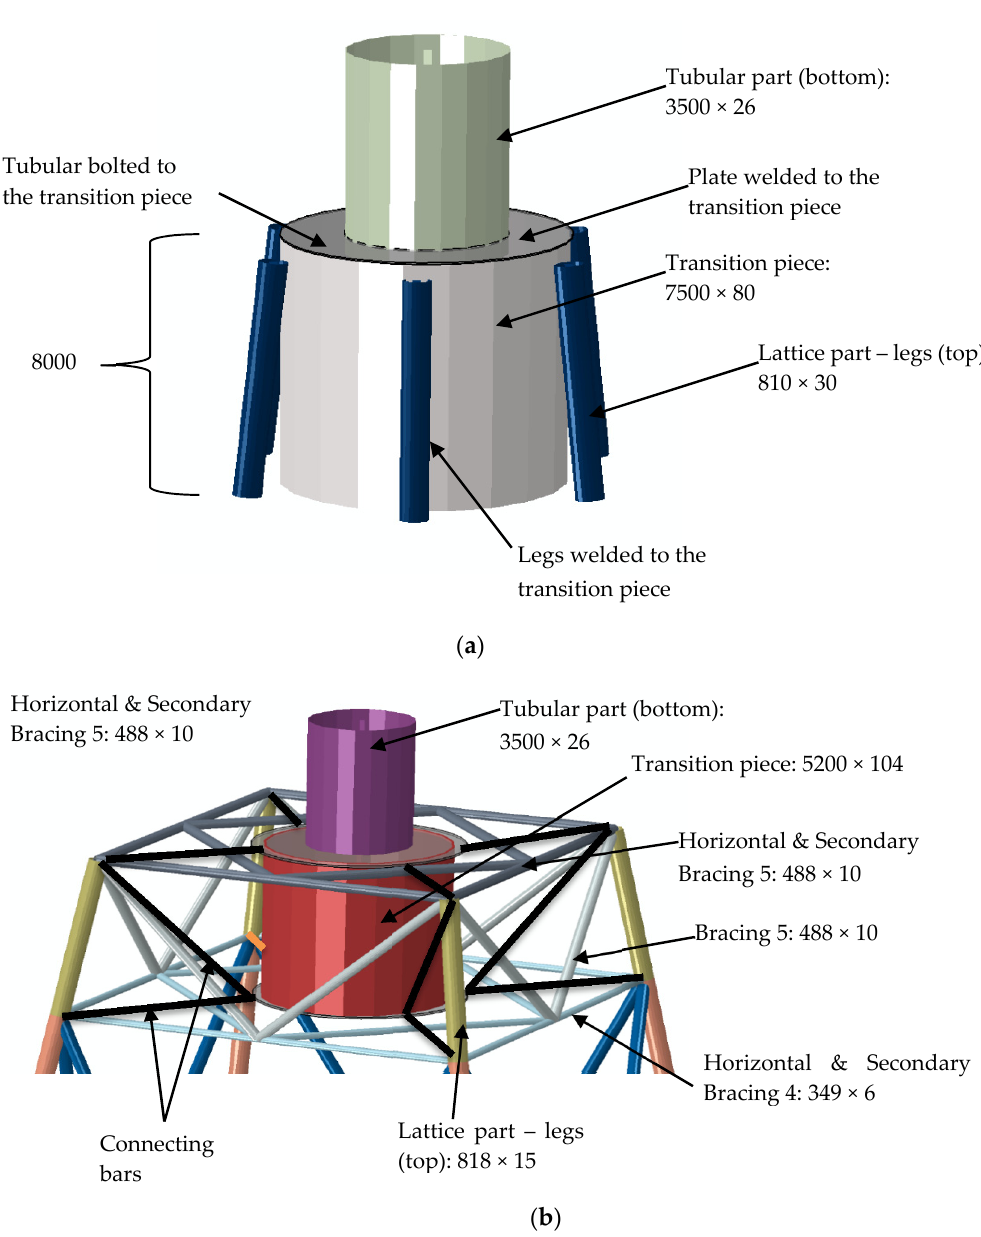
Figure 3. Transition piece (dimensions in mm). ( a ) A 6-legged tower, ( b ) A 4-legged tower.